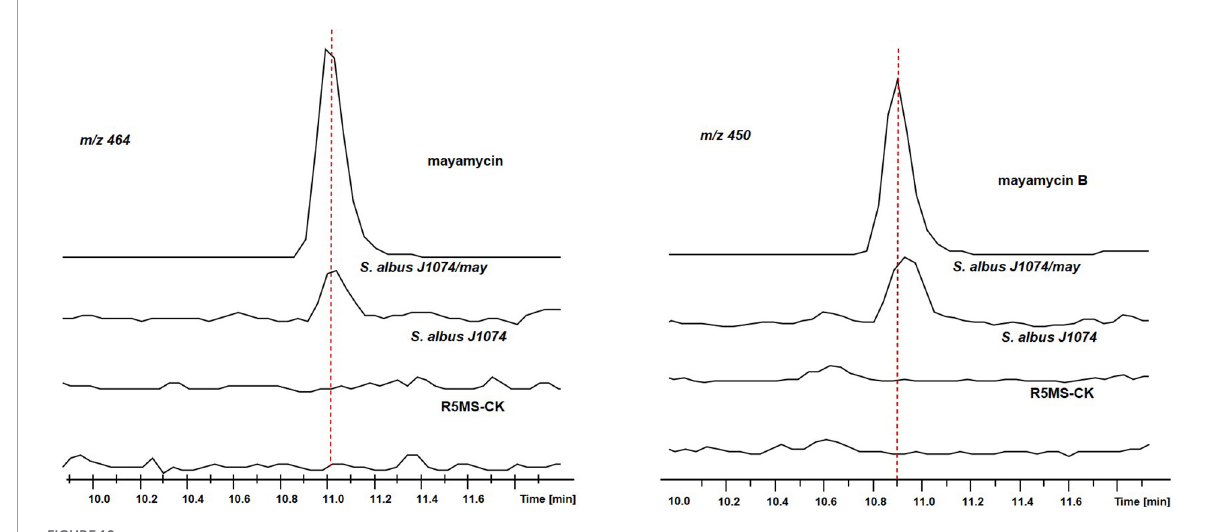
FIGURE10 LC-MS analysis of crude extracts of S. albus J1074 carrying